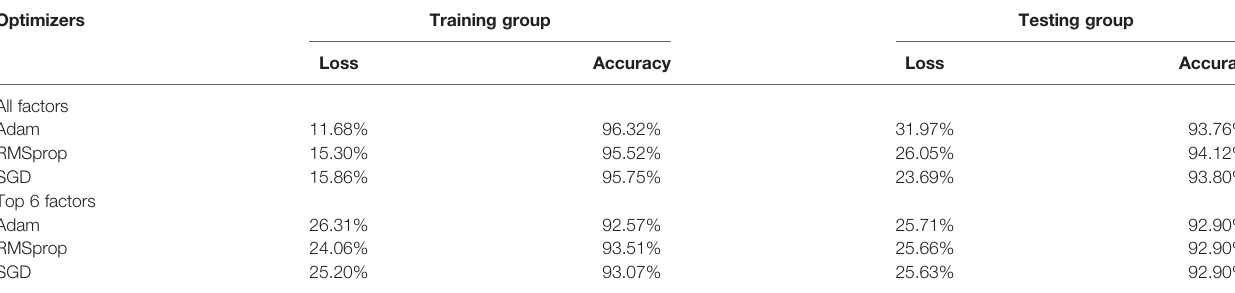
TABLE 4 | Model loss and accuracy of deep learning sequential model in both training and testing